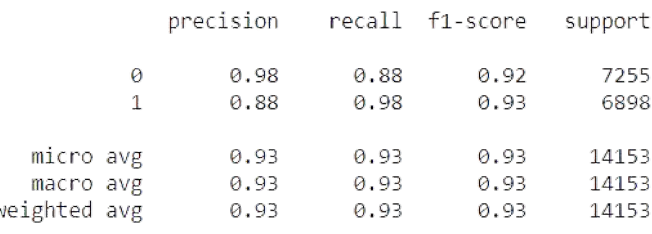
Figure 24. CNN with DeepNetwork metrics.